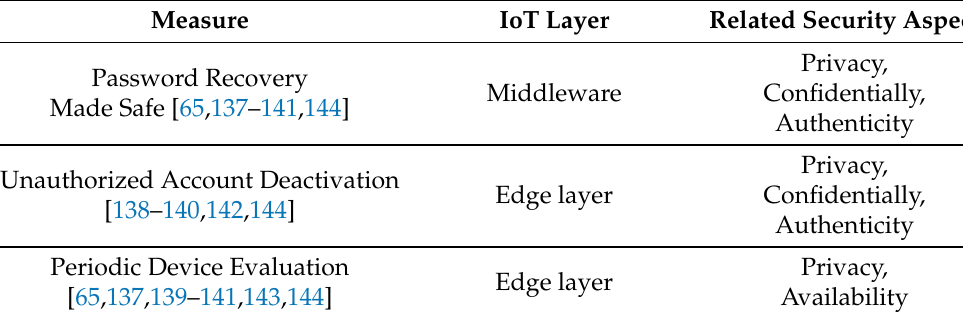
Table 3. Attack Countermeasures for SF and